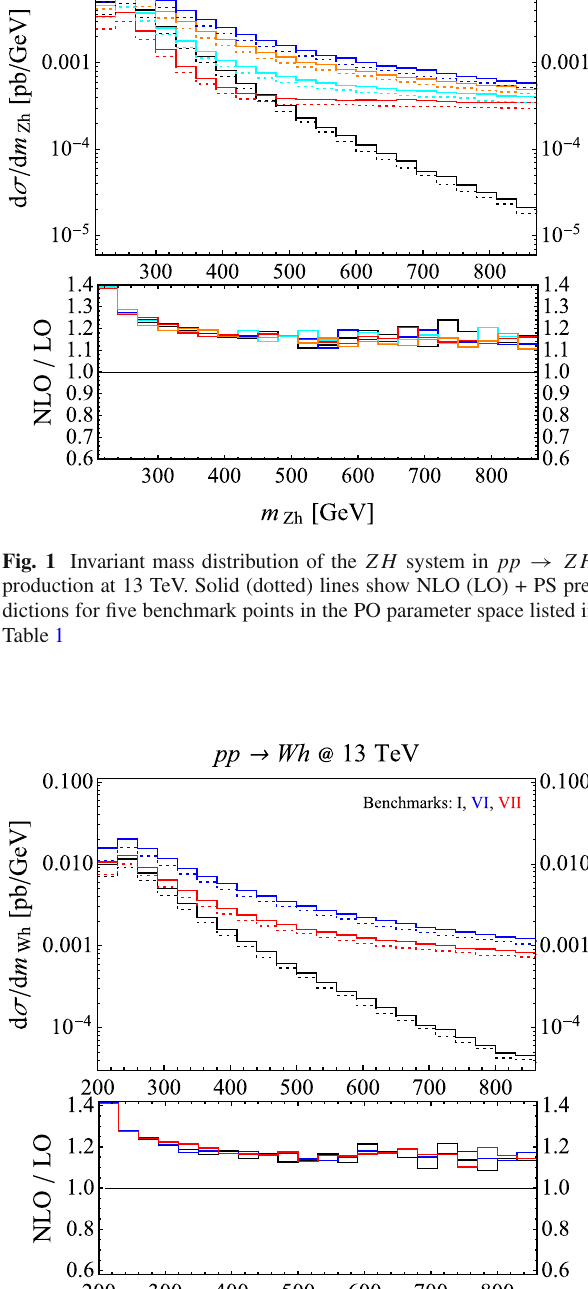
Table 1 Benchmark points in the PO parameter space used to generate events in pp → Z H (I, II, III, IV and V), pp → W H (I, VI and VII), and VBF (I, …, VII) processes. In all benchmarks we set kZZ = kWW